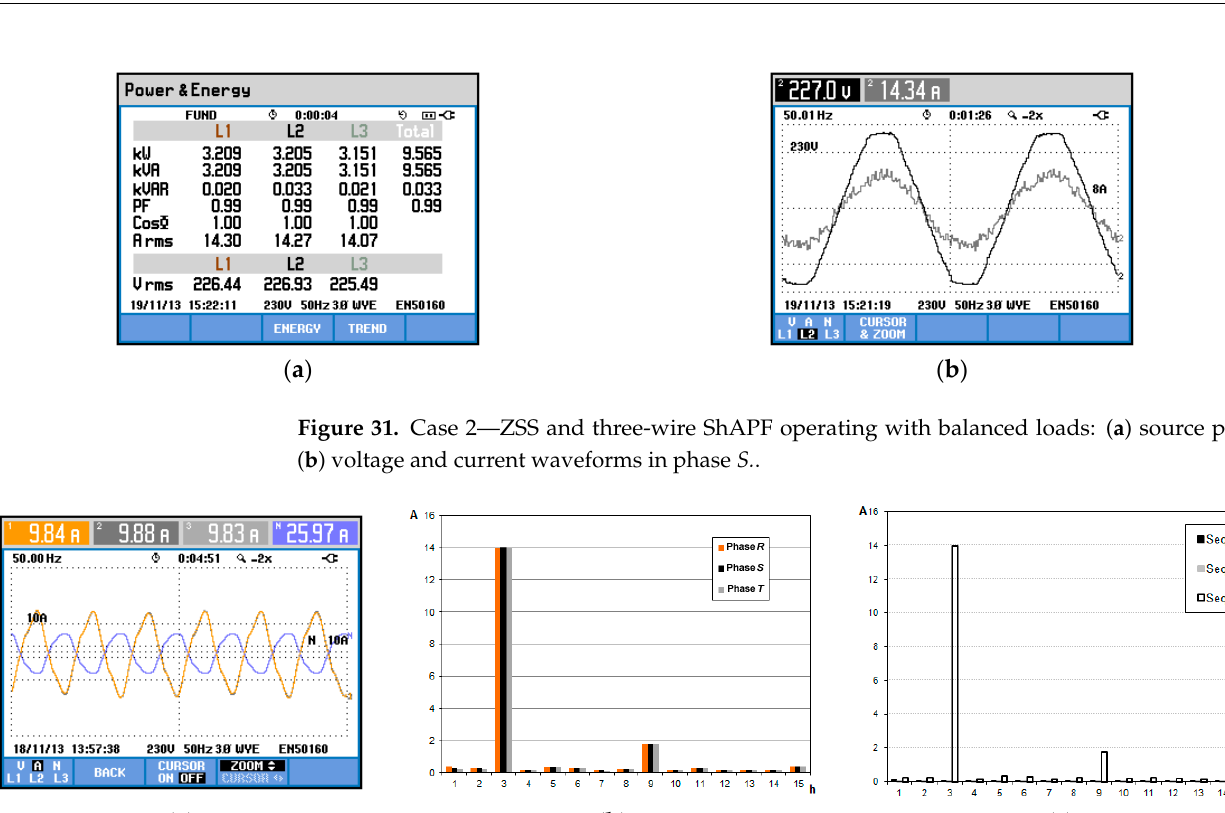
( c ) Figure 29. Case 2 - ZSS and three-wire ShAPF operating with balanced loads: ( a ) three-phase voltages; ( b ) harmonic spectrum of the voltages; ( c ) harmonic spectrum of the voltage sequence components (maximum values). ( a ) ( c ) Figure 30. Case 2 - ZSS and three-wire ShAPF operating with balanced loads: ( a ) three-phase currents; ( b ) harmonic spectrum of the currents; ( c ) harmonic spectrum of the current sequence components (maximum values). The results presented in Figure 30 show a drastic reduction of the third-order current components. This fact was due to the good relationship between the zero-sequence impedance of the system in the PCC and the impedance of the ZSS, favoring the deviation of the zero-sequence current component. As expected, this behavior was provided by the presence of the ZSB in series with the power grid. Another outstanding factor in the joint operation of the ZSS was the significant reduction in the neutral conductor current, going